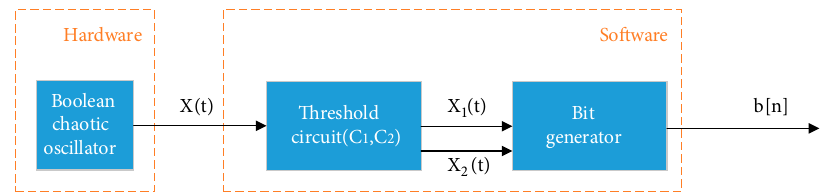
Figure 5: Schematic diagram of random number generation using CMOS Boolean chaotic